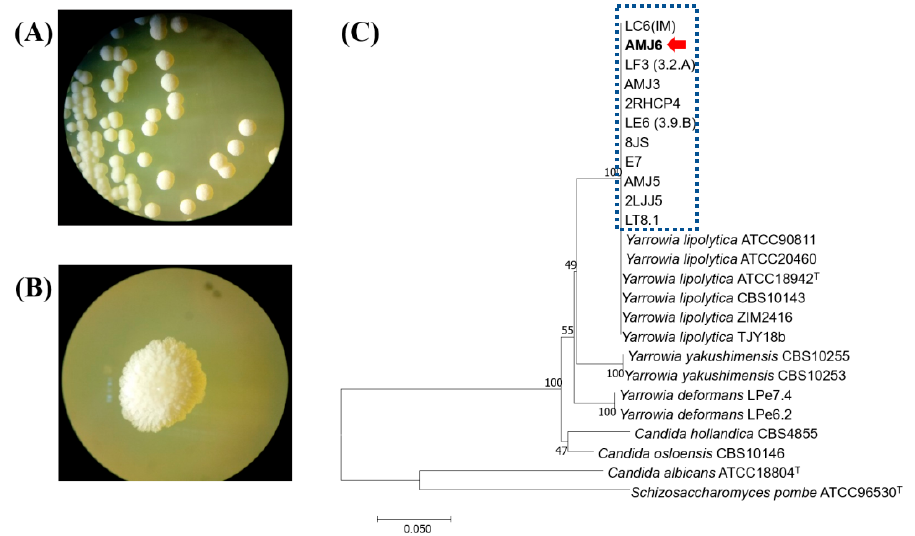
Figure 1 . Culture characteristics of the strains ( A ) AMJ3 and ( B ) AMJ6 observed using a stereomi- croscope with 10× magnification. ( C ) Phylogenetic tree based on the D1/D2 domain of 28S rDNA of the 10 isolated heavy-metal-resistant strains (blue box), which were phylogenetically related to Y. lipolytica . The red arrow indicates the Y. lipolytica AMJ6 strain.